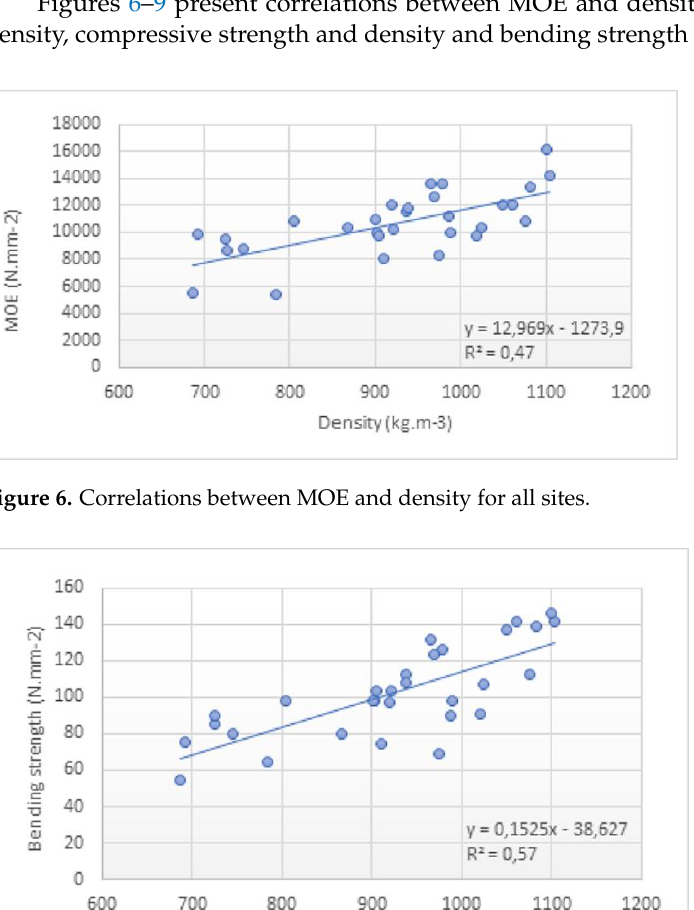
Figure 7. Correlations between bending strength and density for all sites.